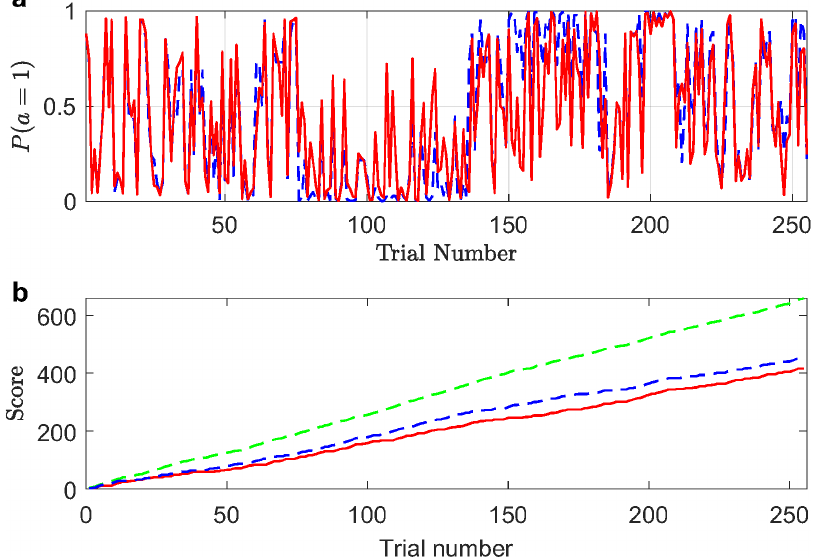
Figure 8. Temporal dynamics of the expectation of response action P ( a ( t ) = 1 ) . ( a ) The expectation of response action P ( a ( t ) = 1 ) generated by our Bayesian agent (red solid line) match closely to M 1 the probabilistically optimal expectation of response action P ∗ ( a ( t ) = 1 ) (blue dashed line). ( b ) The cumulative reward obtained by our Bayesian agent (red solid line) tightly follows the cumulative reward of the probabilistically optimal expectation of response action P ∗ ( a ( t ) = 1 ) given by the informed agent (blue dashed line). The ideal observer, who knows the actual outcomes of the bandit in advance, has the highest cumulative reward of the